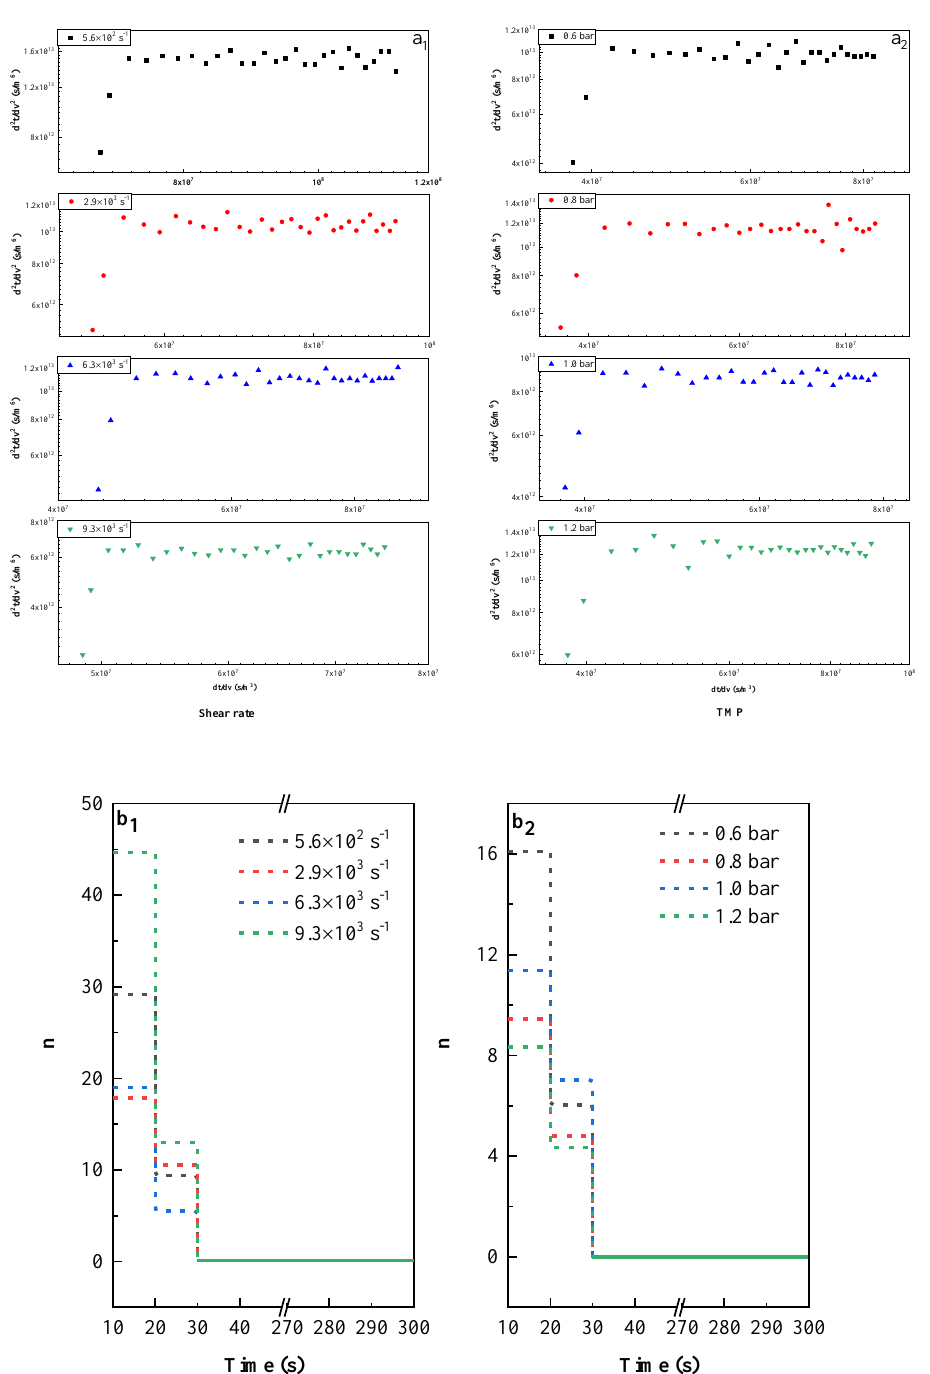
Figure 11. Fitting of experimental data at early stage of ultrafiltration (up to 5 min) with Herman (cid:48) s model using equation d 2 t dt 2 = K at different conditions ( a 1 , a 2 ); the evolution of blocking coefficient ( n ) over time for different conditions ( b 1 , b 2 ). PVDF 50kDa was used in this section.